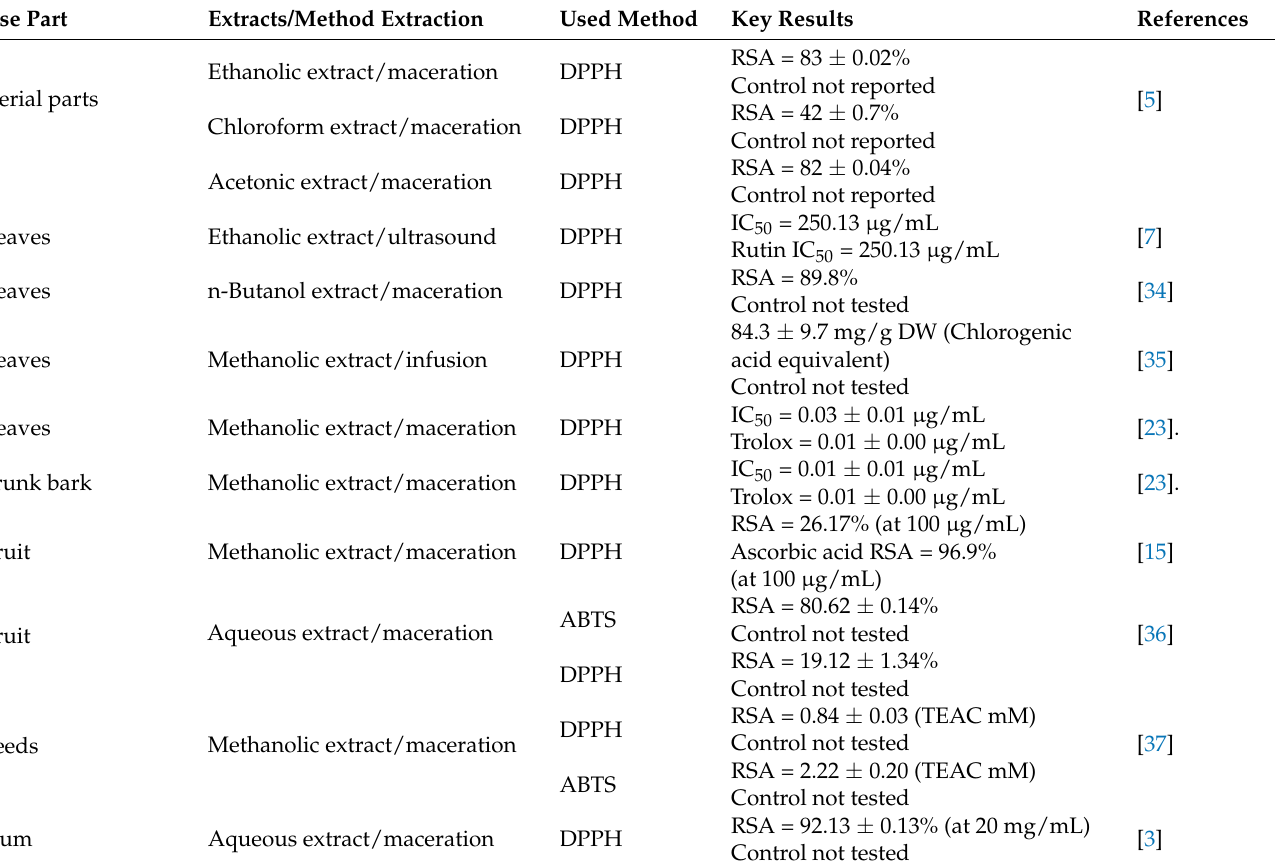
Table 5. Antioxidant activity of V. tortilis